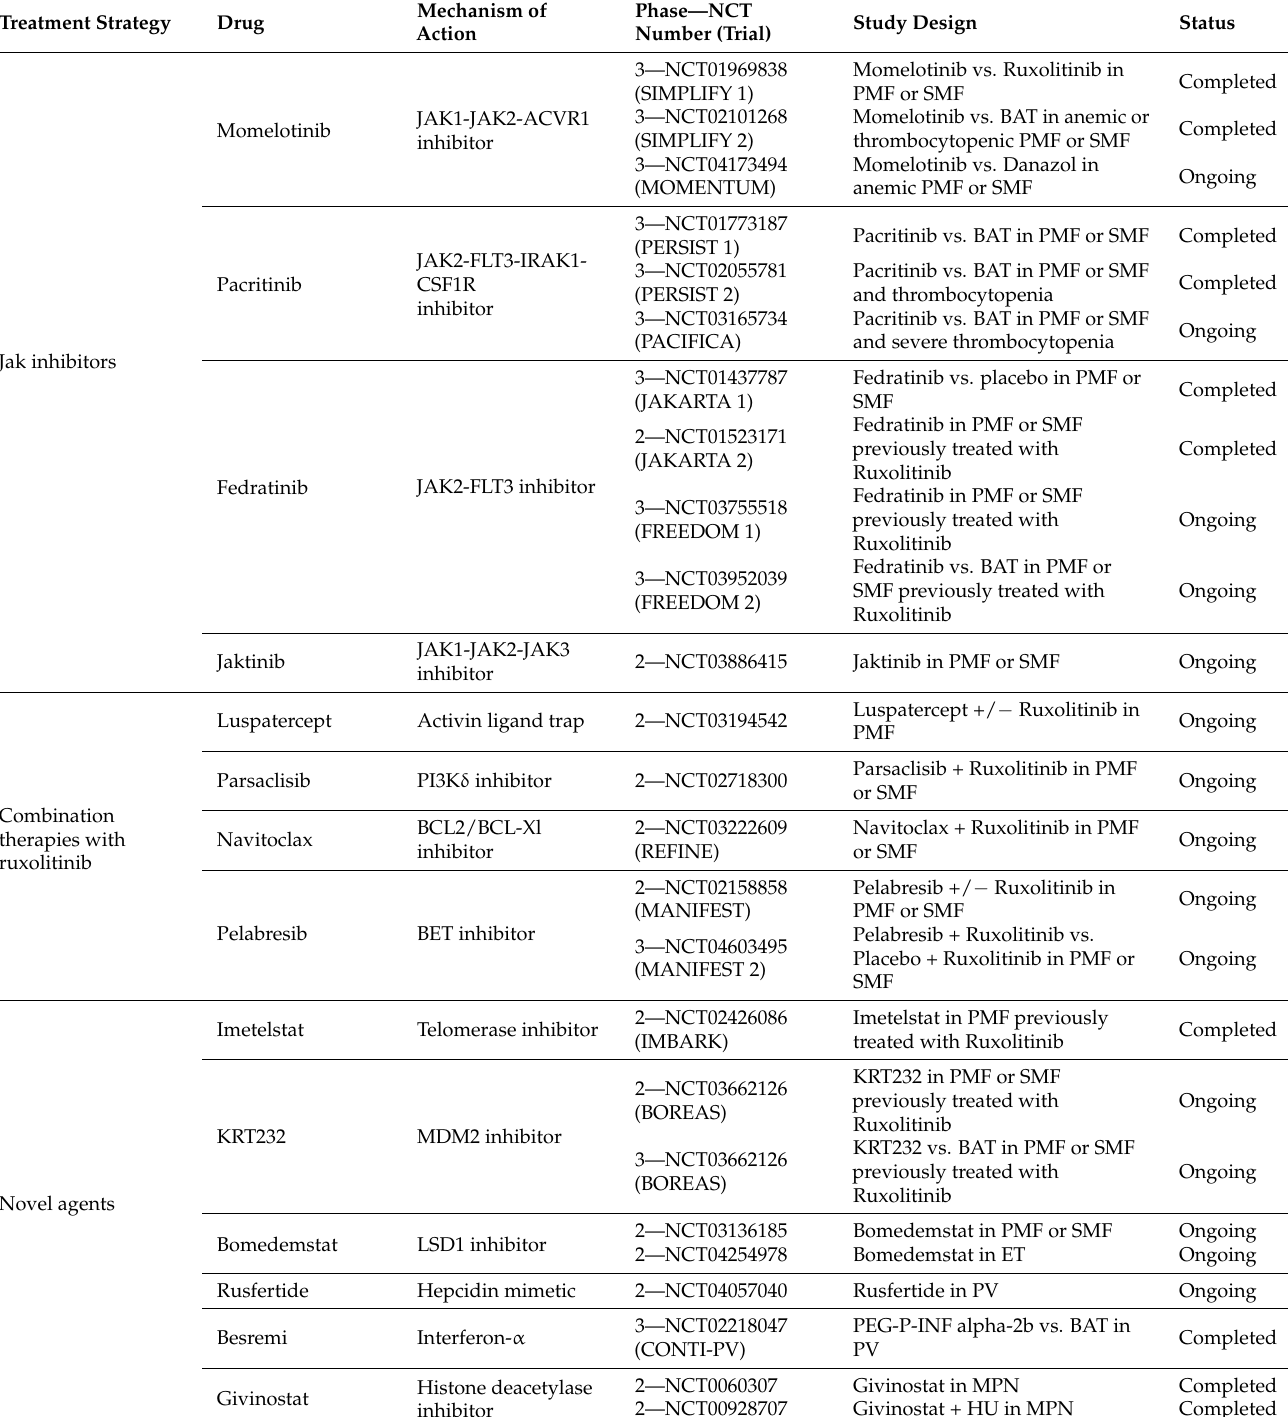
Table 1. Reported at the end of the manuscript: 5.1 New JAK